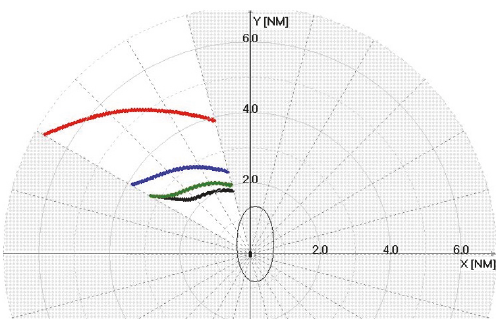
Figure 24: Action lines for stand-on crossing encounter with a target, whose true speed is 18 knots. Assumed are turns of 30 ∘ to starboard without speed reduction (red) by 9 knots (the progress is marked in black).